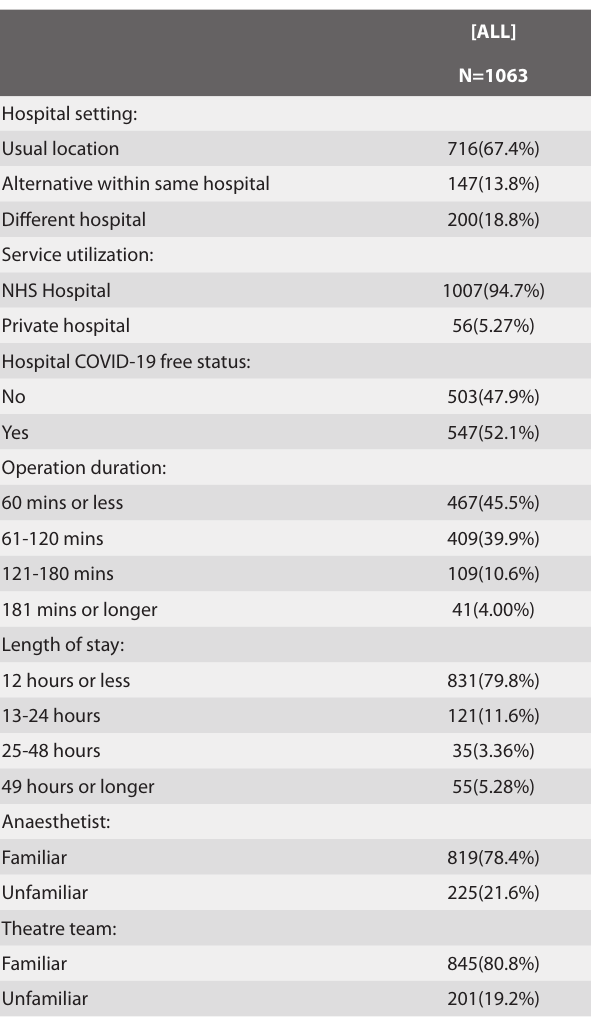
Table 4. Familiarity of surgical environment.